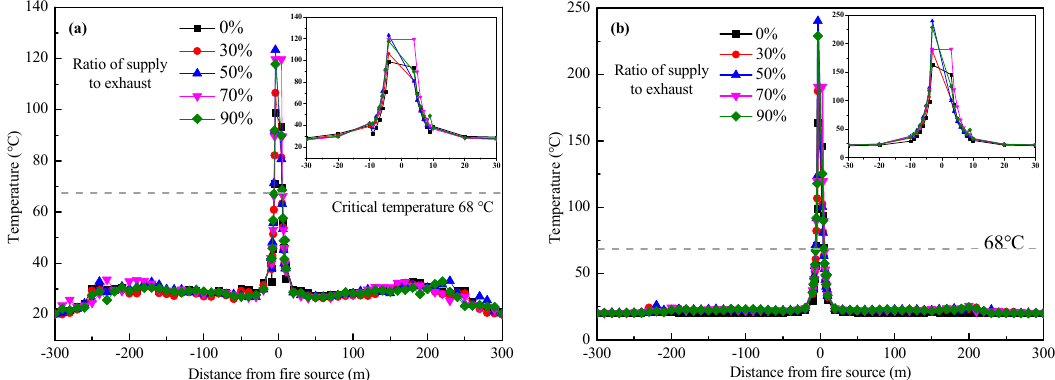
Figure 5. Temperature at safe height under different air supply volume: ( a ) sidewall exhaust; ( b ) top exhaust. ( b ) top